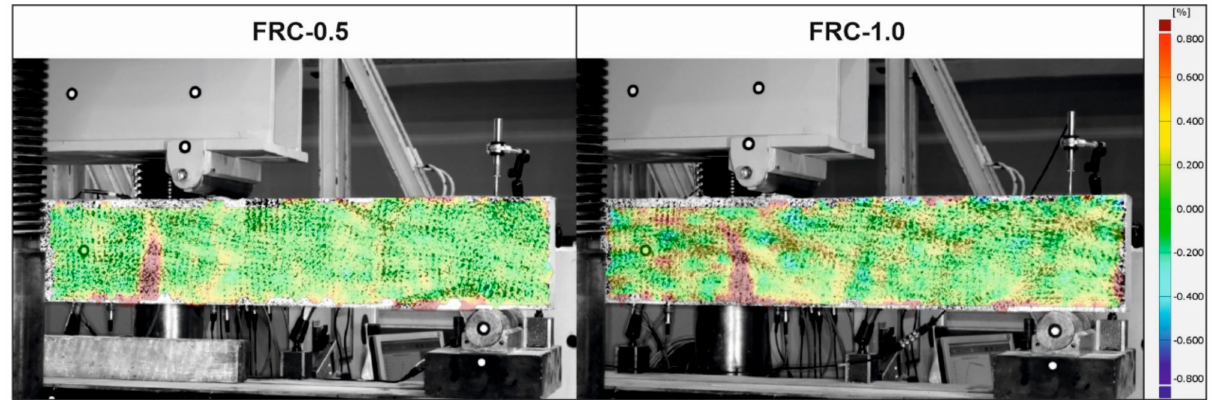
Figure 14. Distribution of the principal strains on the front surface of the beams based on